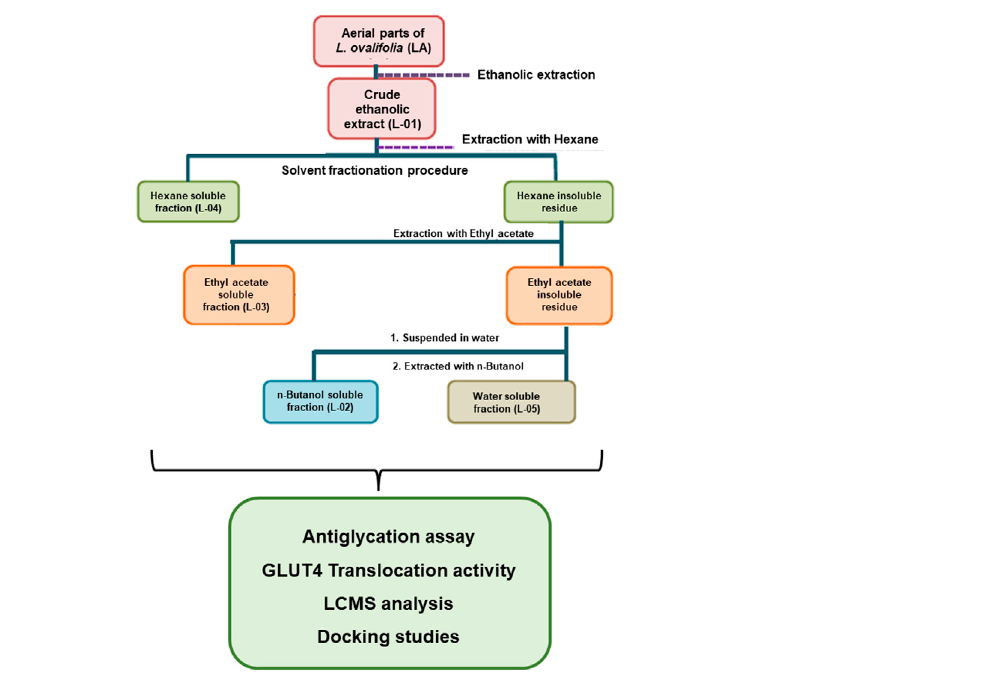
FIGURE 4 Schematic representation of bioactivity-guided fractionation of L. ovalifolia